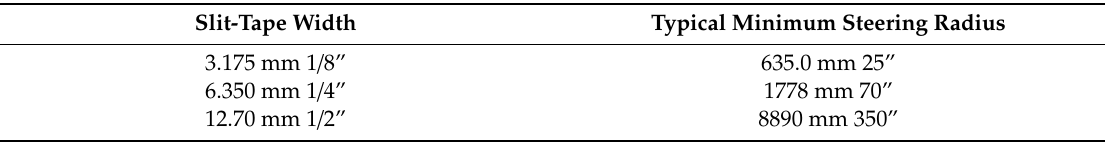
Table 1. Variation of minimum steering radius with slit-tape width for a 102 mm track width [50].